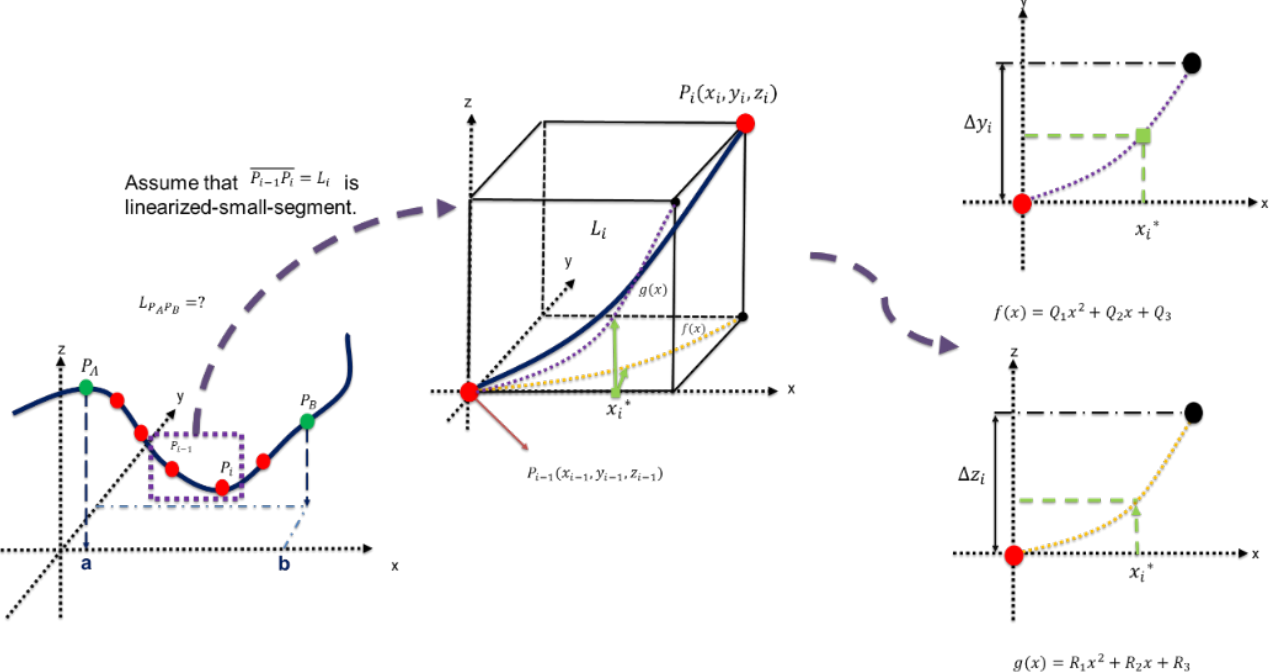
Figure 1. Scheme for the Derivation of Curved Line Length Equation in 3D.